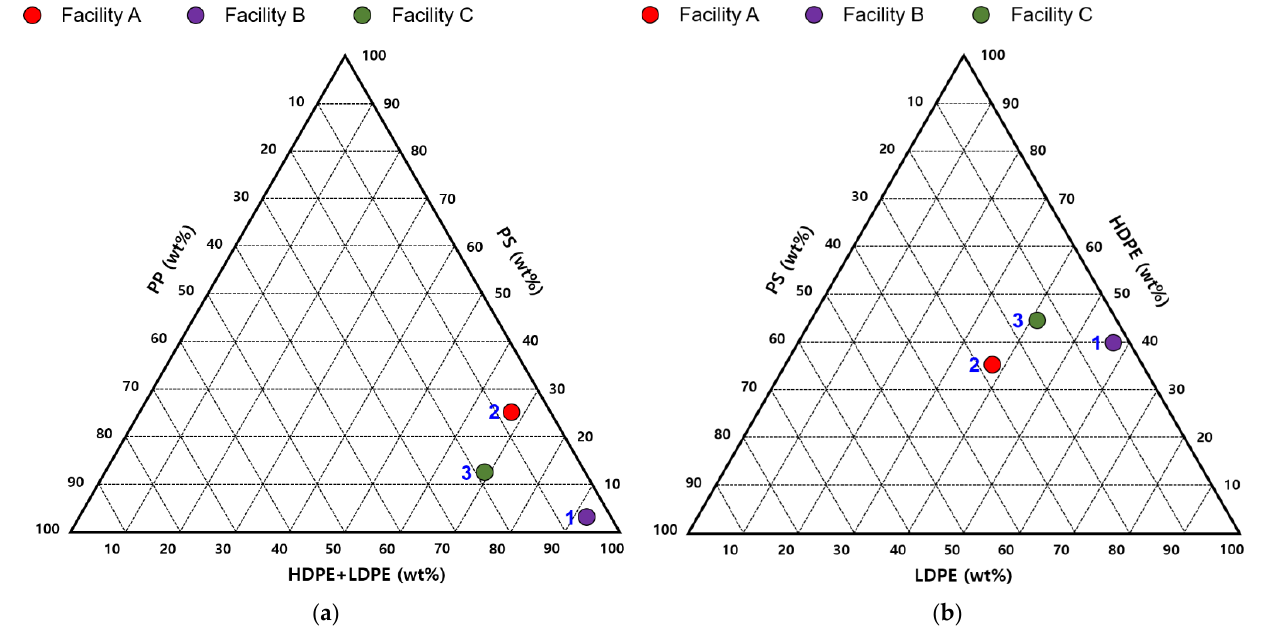
Figure 3. Ternary plot of plastic waste feedstock with respect to oil yield: ( a ) PP, HDPE + LDPE and PS; ( b ) PS, LDPE and HDPE.